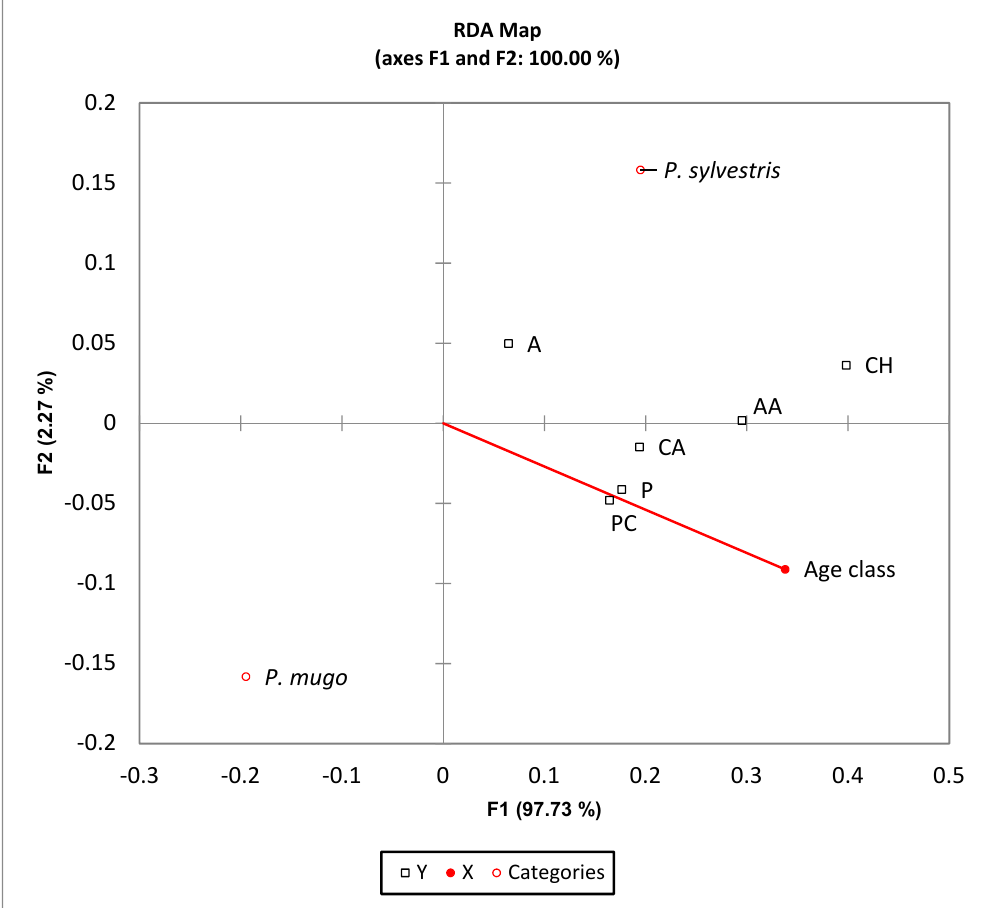
Figure 2. Dependence of different carbon sources (indicated by average well color development (AWCD) on age class and pine species. Carbon substrate groups: AA: amino acids; A: amines and amides; P: polymers; PC: phenolic compounds; CA: carboxylic acids; CH: carbohydrates; Redundancy analysis (RDA).